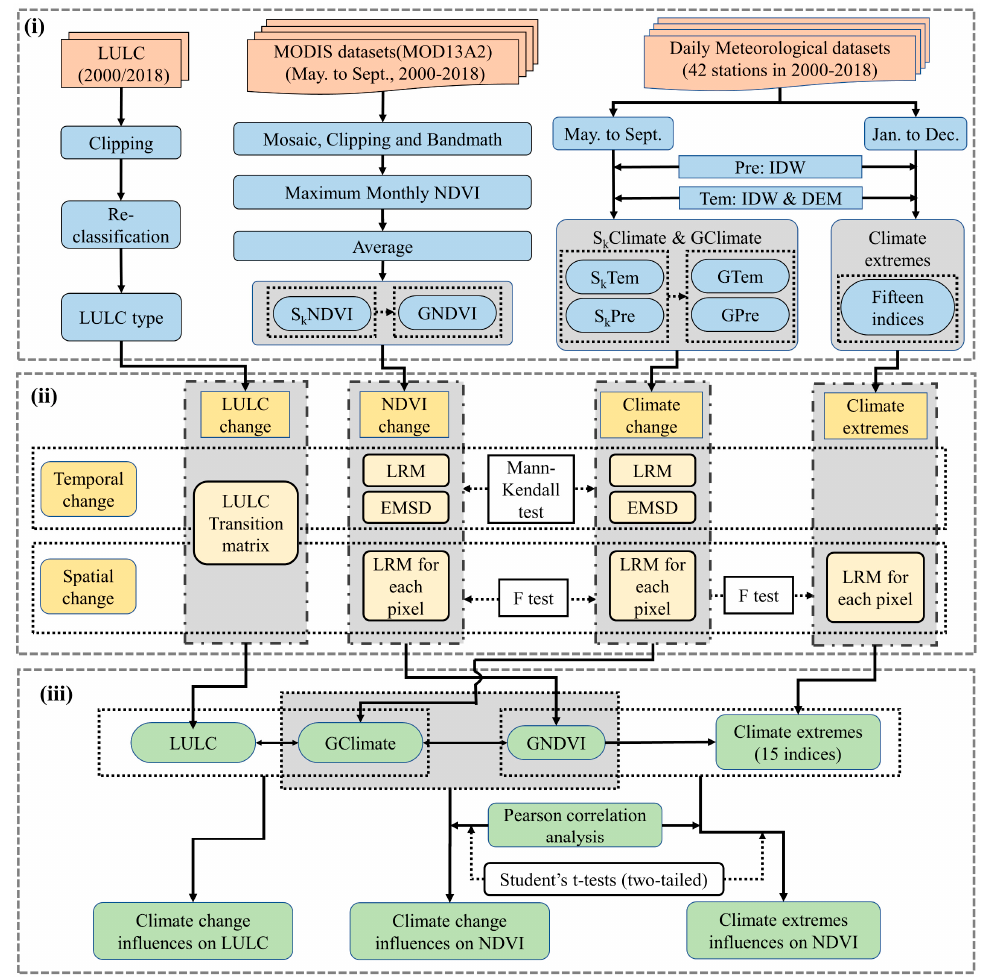
Figure 2. Technical flow chart. ( i ) Data preprocessing, ( ii ) spatio-temporal characteristics of the NDVI and climate change, and ( iii ) the effects on the NDVI and LULC by the climate change. Tem and Pre denotes the temperature and precipitation, respectively. S k includes S 1 , S 2 , S 3 , and S 4 , represents spring, summer, autumn, and growing seasons, respectively. IDW is the Inverse Distance Weighting; ESMD is the Extreme-point Symmetric Mode Decomposition; LRM is the Linear Regression Method.